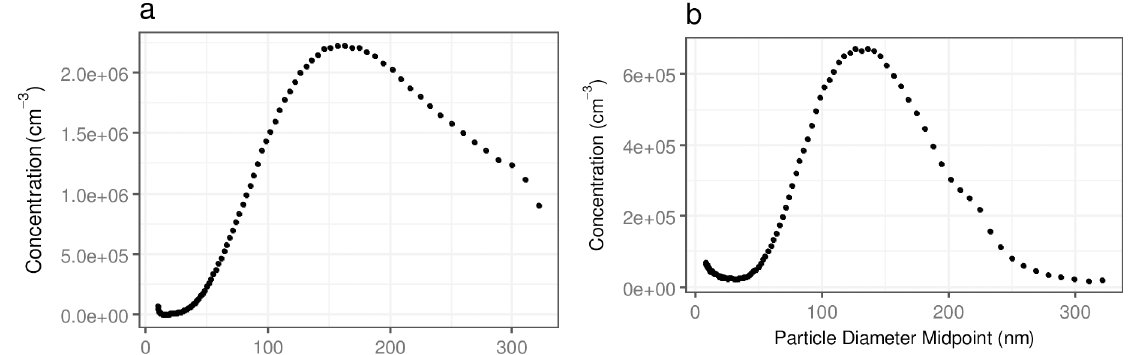
Fig 1. Particle size distributions as measured by the SMPS for a) Cigarette smoke particles b) Petrol exhaust particles. The respective number size distributions for different times were aggregated to the total size distribution.